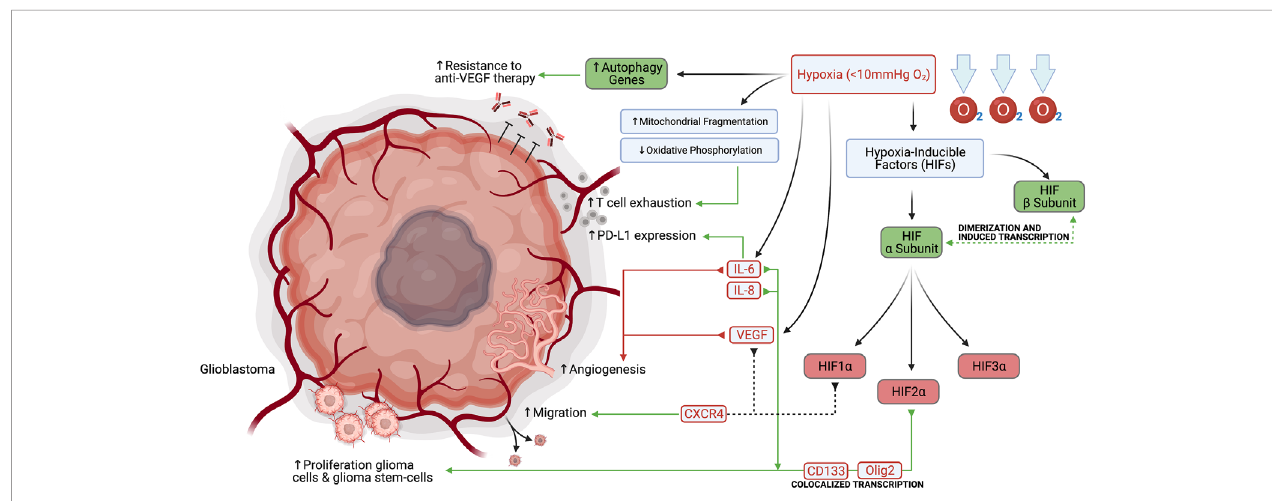
FIGURE 1 | Hypoxia promotes glioblastoma and glioblastoma stem-cell proliferation, migration, angiogenesis, PD-L1 expression, and resistance to anti-VEGF